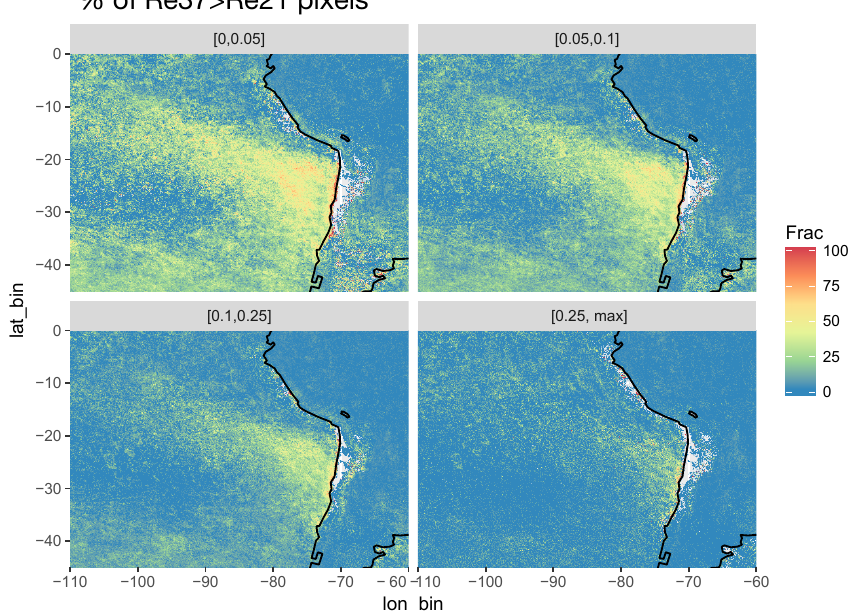
◦ resolution MODIS